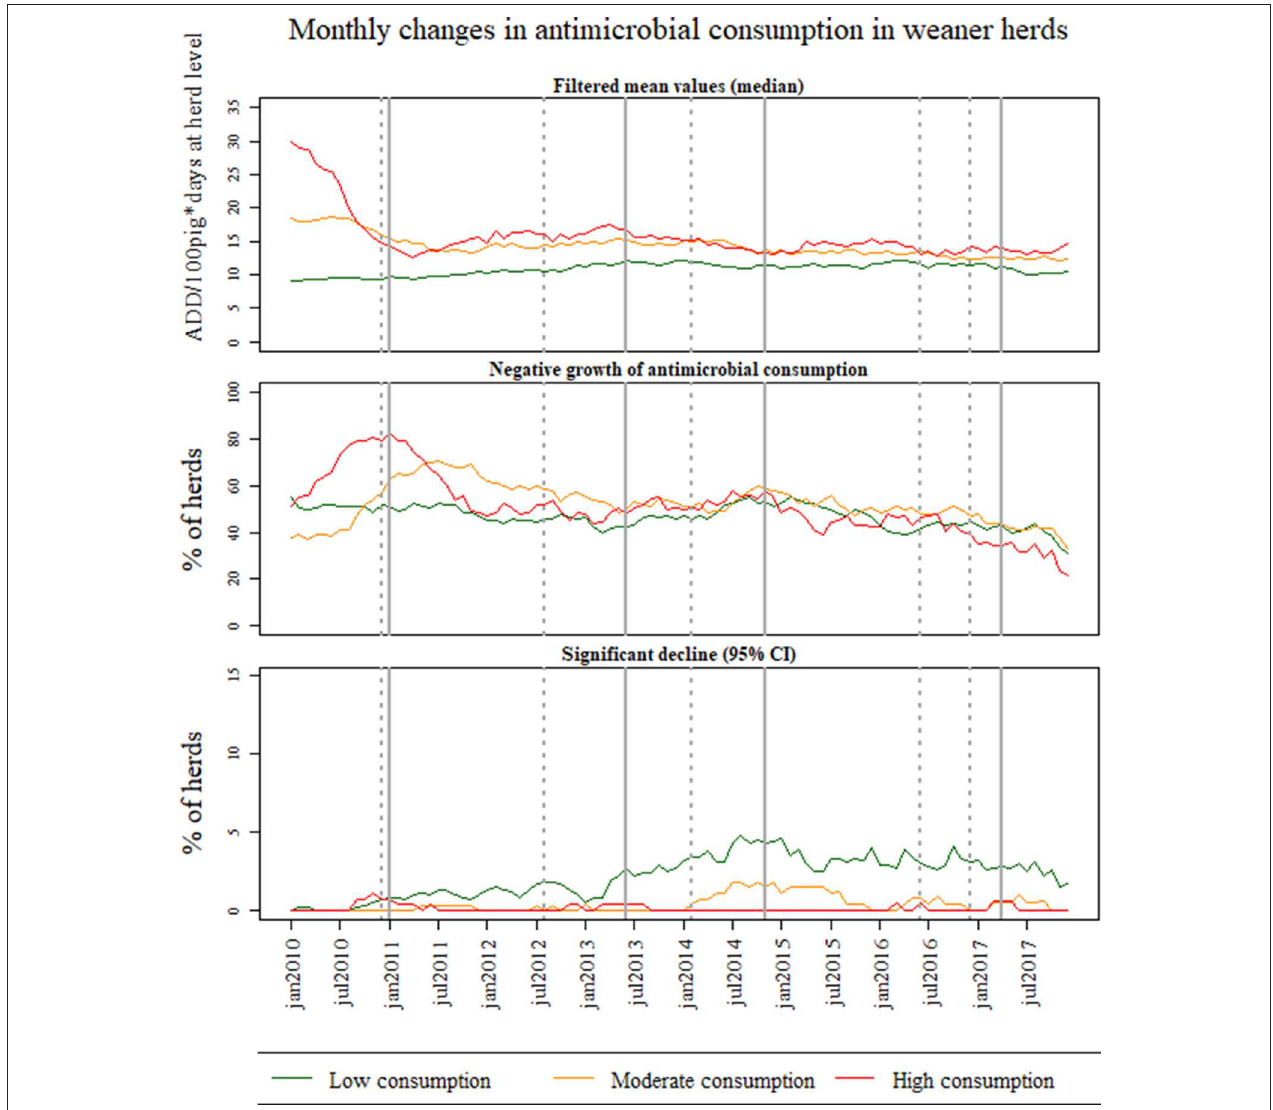
FIGURE 2 | Monthly changes in antimicrobial consumption in Danish weaner herds between January 2010 and December 2017 for all Danish farms. The farms were divided into three groups based on the level of antimicrobial use (low, medium, and high) in 2008 and 2009. For each group of antimicrobial consumption, the graphs depict (1) the median of the filtered mean values obtained at farm-level based on the Dynamic Linear Model (DLM) with a linear trend component, (2) the percentage of herds with negative growth based on the DLM, and (3) the percentage of herds with a significant decline on the trend component of the DLM using 95% credible intervals